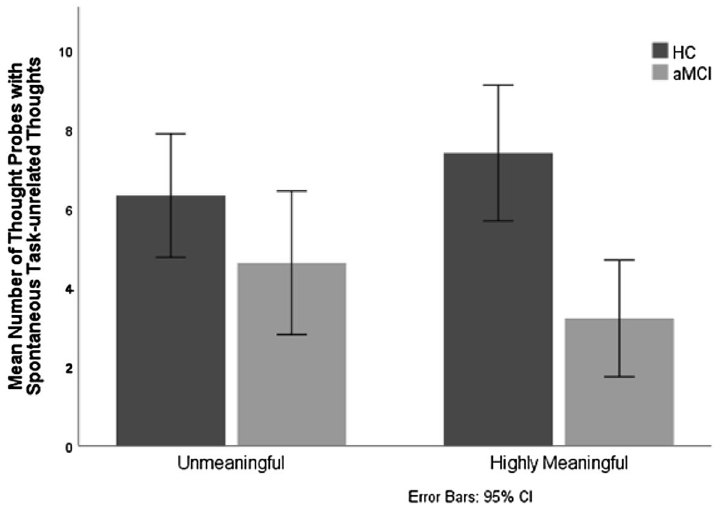
Figure 2. Mean number of thought probes with spontaneous task-unrelated thoughts as a function of stimulus type (highly meaningful vs unmeaningful) and group (aMCI participants vs. healthy controls).